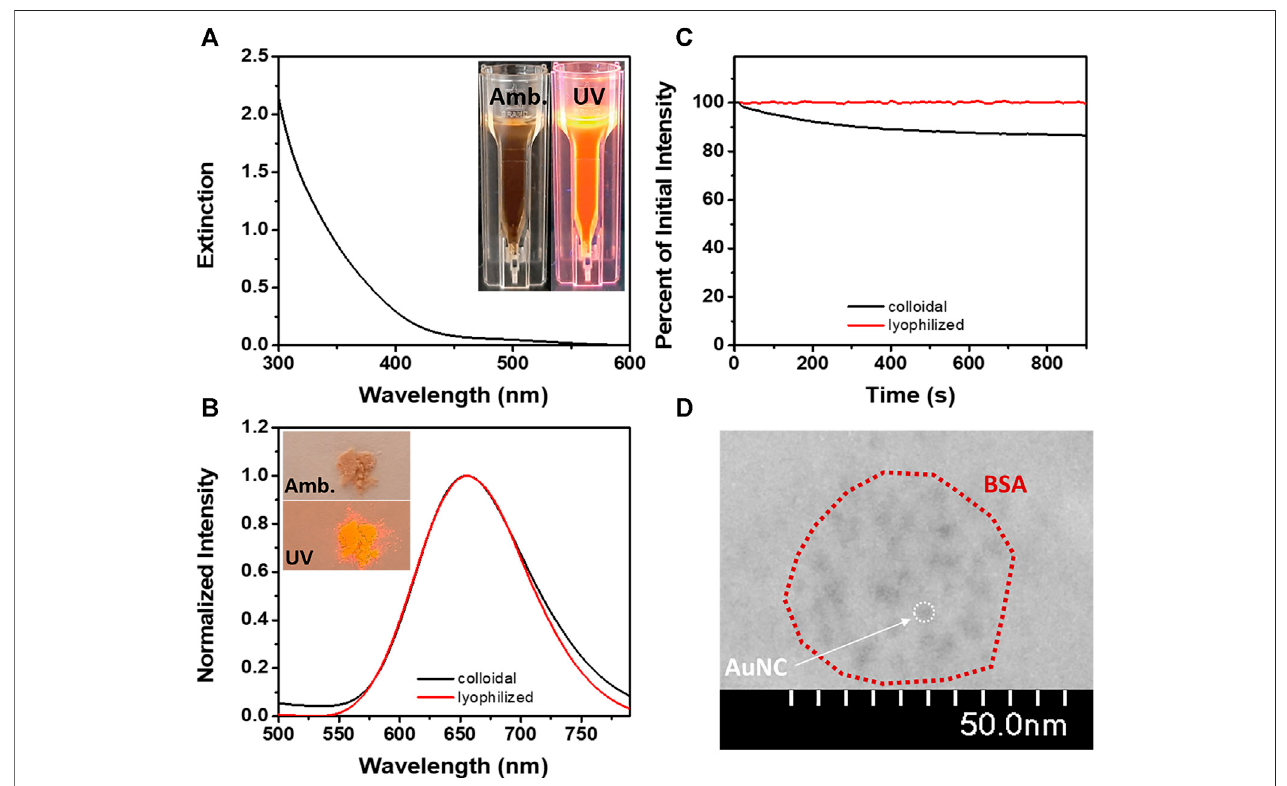
FIGURE 1 | (A) The extinction spectrum of BSA-AuNCs (inset – images of BSA-AuNCs in aqueous solution under amb. and UV light). (B) The emission spectra of BSA-AuNCs in solution (black line) and as lyophilized powder (red line) at an excitation of 405 nm (inset – images of BSA-AuNCs as lyophilized powder under amb. and UV light). (C) ThephotostabilityofBSA-AuNCs in solution(black line) and aslyophilized powder(redline) under continuous excitationat 405 nm for15 min. (D) HR-TEM image of the